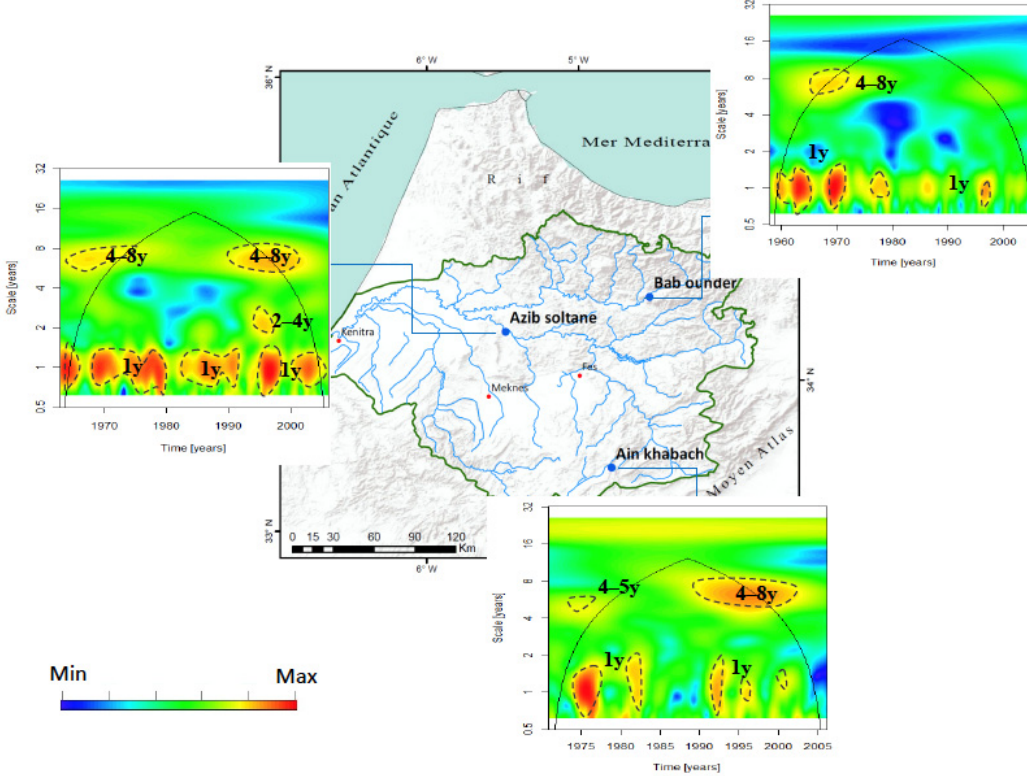
Figure 7. Spectra of continuous wavelet analysis of rainfall in the Sebou